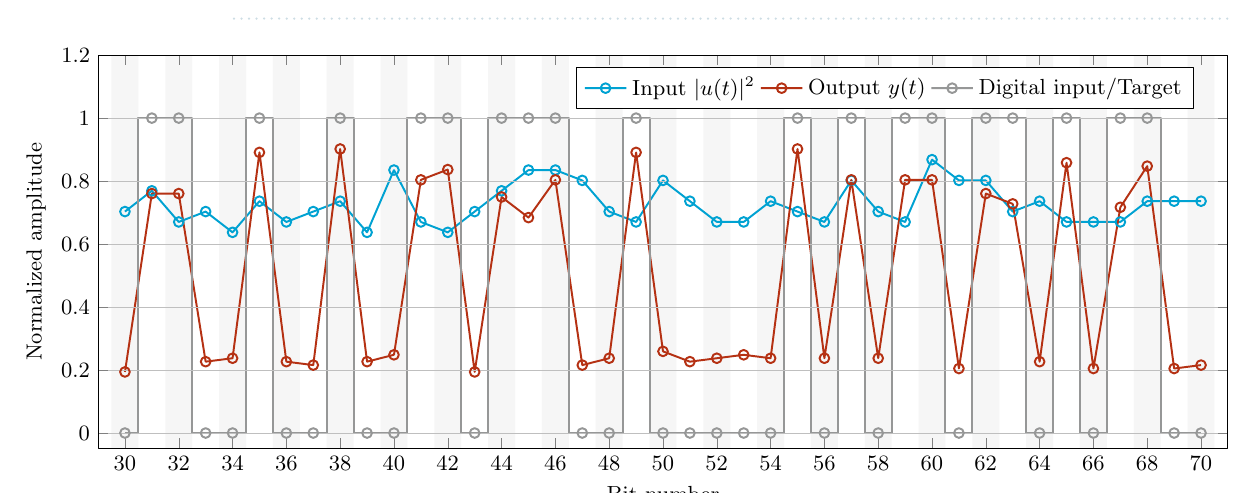
Figure 7. 1-bit delayed XOR. BER as a function of the time from the begin of the bit for the different models indicated in the inset. Simulation parameters: input power 4 dBm, bit-rate 5 Gbps, BER statistical limit 10 − 5 .